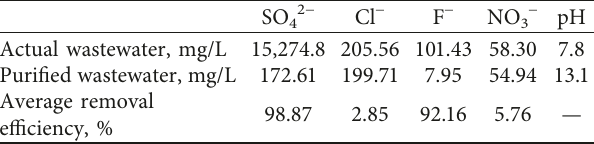
Table 1: Results of anions removal.